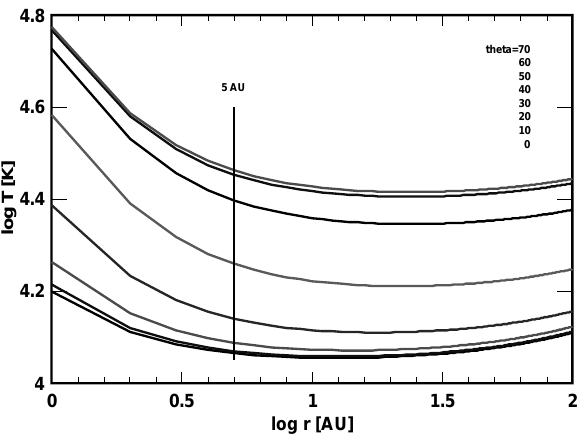
Fig. 3. Shown versus solar distance r is the temperature T 1 of pri- mary solar wind ions in units of [Kelvin] for various heliographic latitudes, i.e. for ϑ = 0 , 10 , 20 , 30 , 50 , 60 , 70 degrees. Con- sistent with the variation of ϑ , solar wind velocity, density, the Alfv´en speed and the energy input parameters g 0 and G 0 have been changed according to prescriptions derived in the text. The initial boundary values for T at 5 AU have been taken from McComas et 1 al.